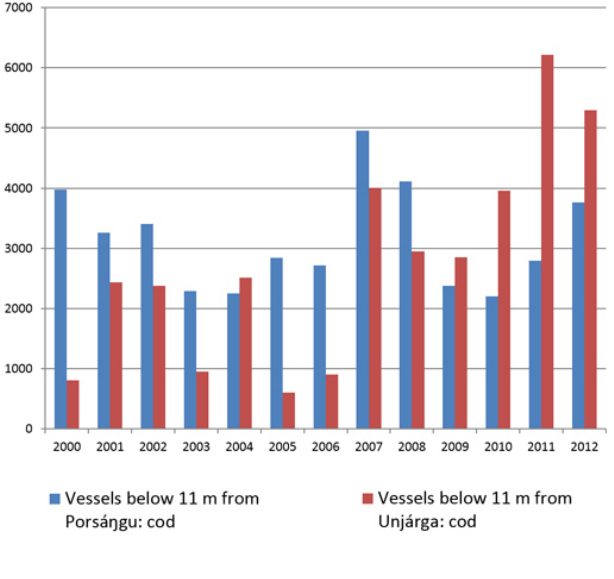
Fig. 4 . Deliveries of cod (in 1000 Norwegian kroner) landed by vessels below 11 m from Porsá η gu and Unjárga in the period 2000-2012. Municipalities of landings are all over Finnmark, but most of the catch is landed in the vessels’ home municipality or close by. Source: Directorate of Fisheries